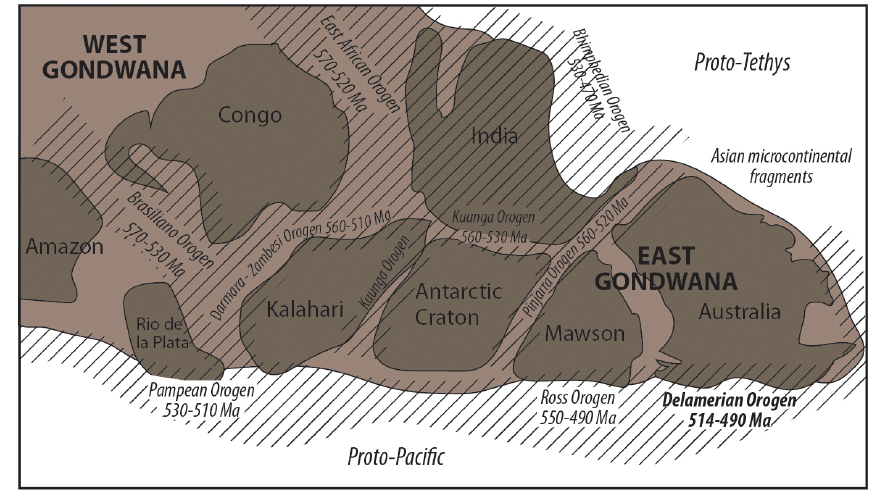
Figure 1. Location of the Delamerian Orogen with respect to eastern Gondwanan terranes and Pan-African orogens. Modified from Cawood et al.